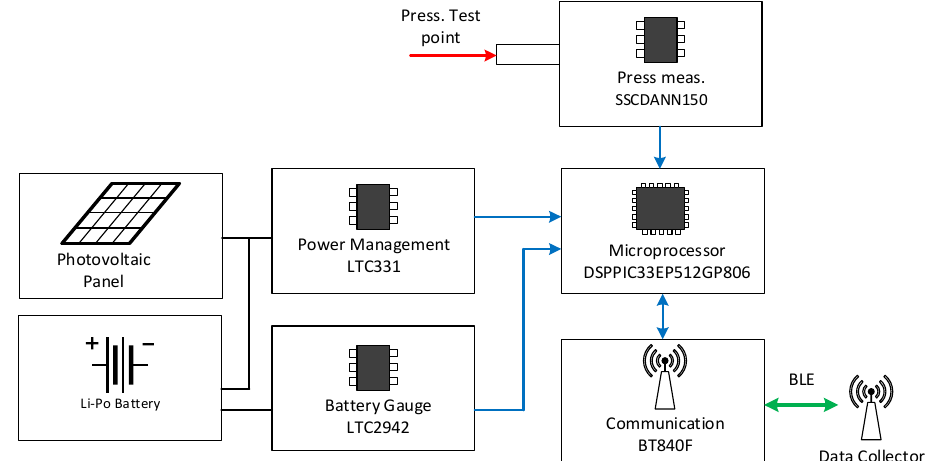
Figure 1. Hardware architecture.